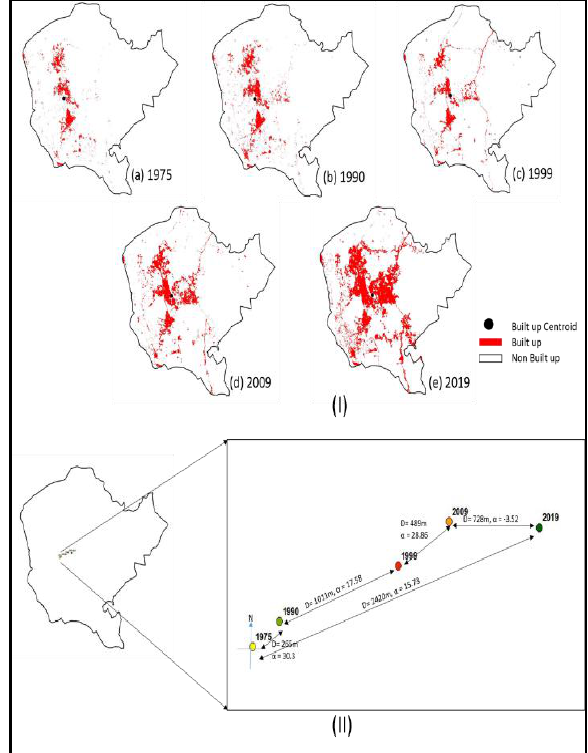
Figure 4 (I) Built-up Area Centroids (II) Centroid Shift Trajectory